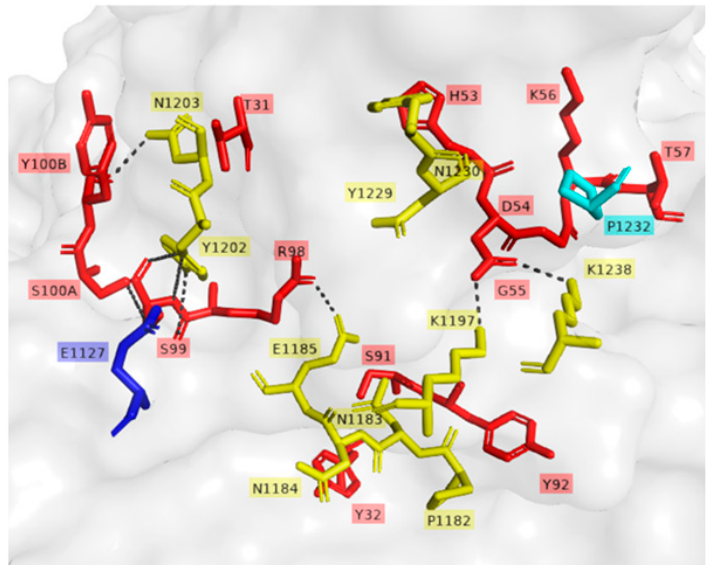
Figure 7. In silico prediction of TT-140 binding to TeNT. Interaction residues of TT-140 and TeNT complex. Representation of hydrophobic and hydrogen bonds’ interaction. Residues of TeNT are marked in yellow and residues of TT-140 are marked in red. TeNT residues of the predicted epitopes by peptide array for TT-140 and TT-117 are marked in cyan and blue, respectively. Black dashed lines represent hydrogen bonds.